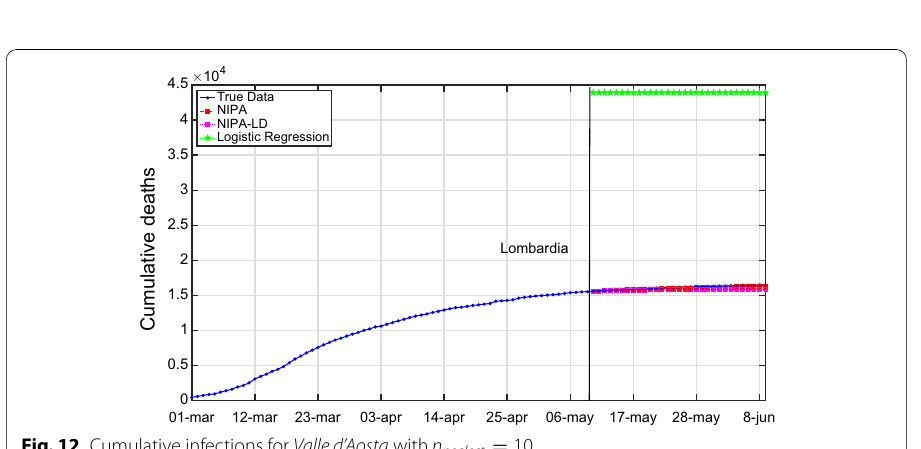
Fig. 12 Cumulative infections for Valle d’Aosta with n neglect = 10